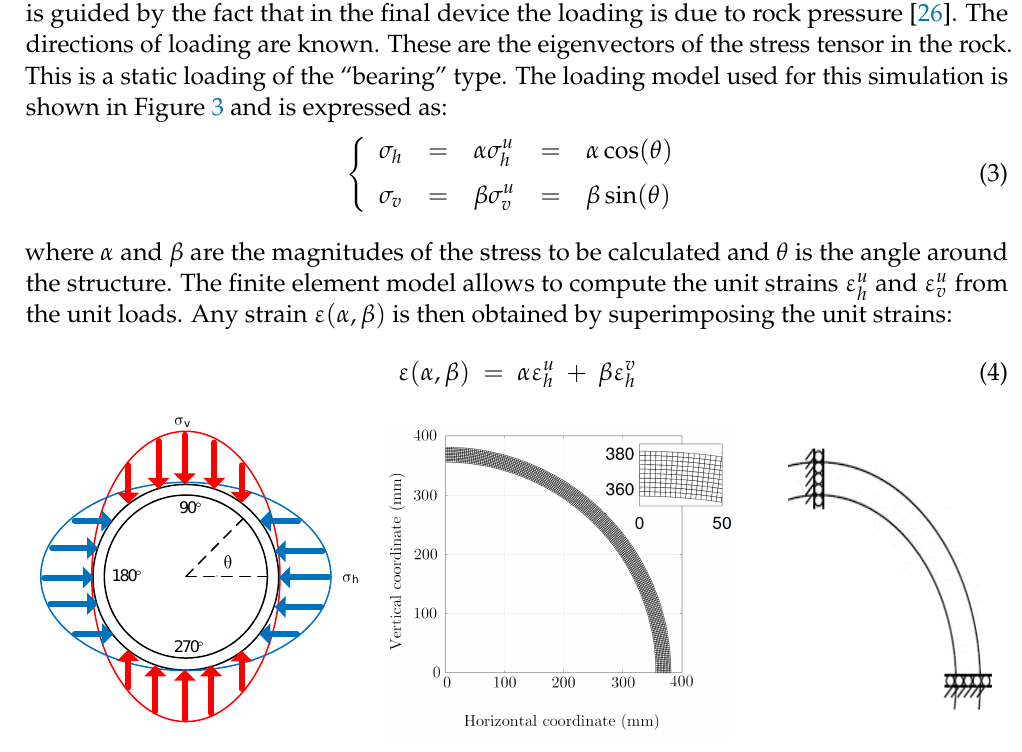
Figure 3. Modeling of static loading along the main horizontal and vertical stress directions σ h and σ v imposed on the HLW cell model. The structure being symmetrical, only the quarter is modeled with a mesh of 180 elements in the circumference and 10 elements in the thickness, the boundary conditions are also